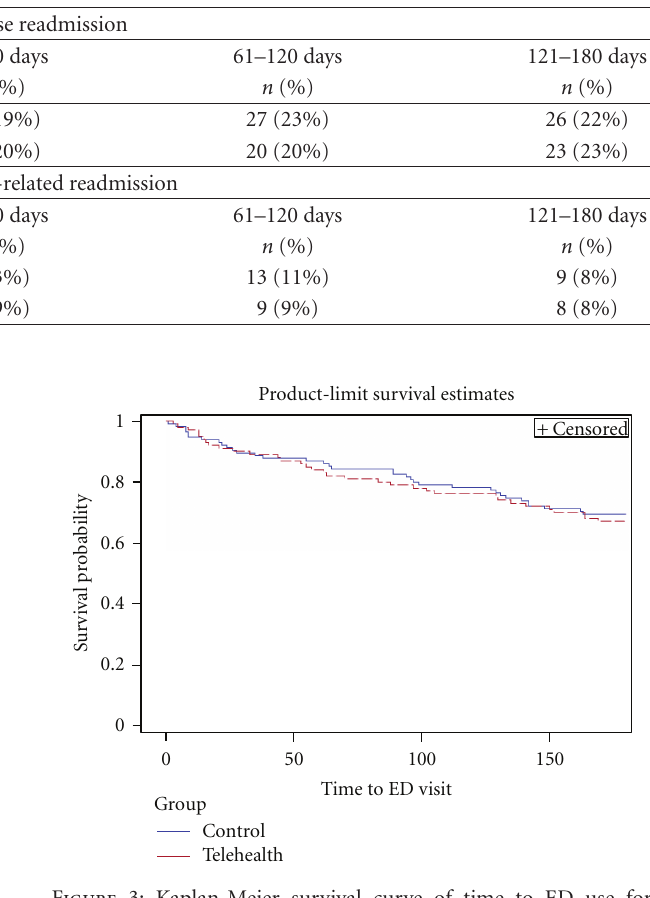
Figure 2: Kaplan-Meier survival curve of time to first all-cause readmission or death for telehealth group versus control usual care group (LR P -value = 0 . 585).